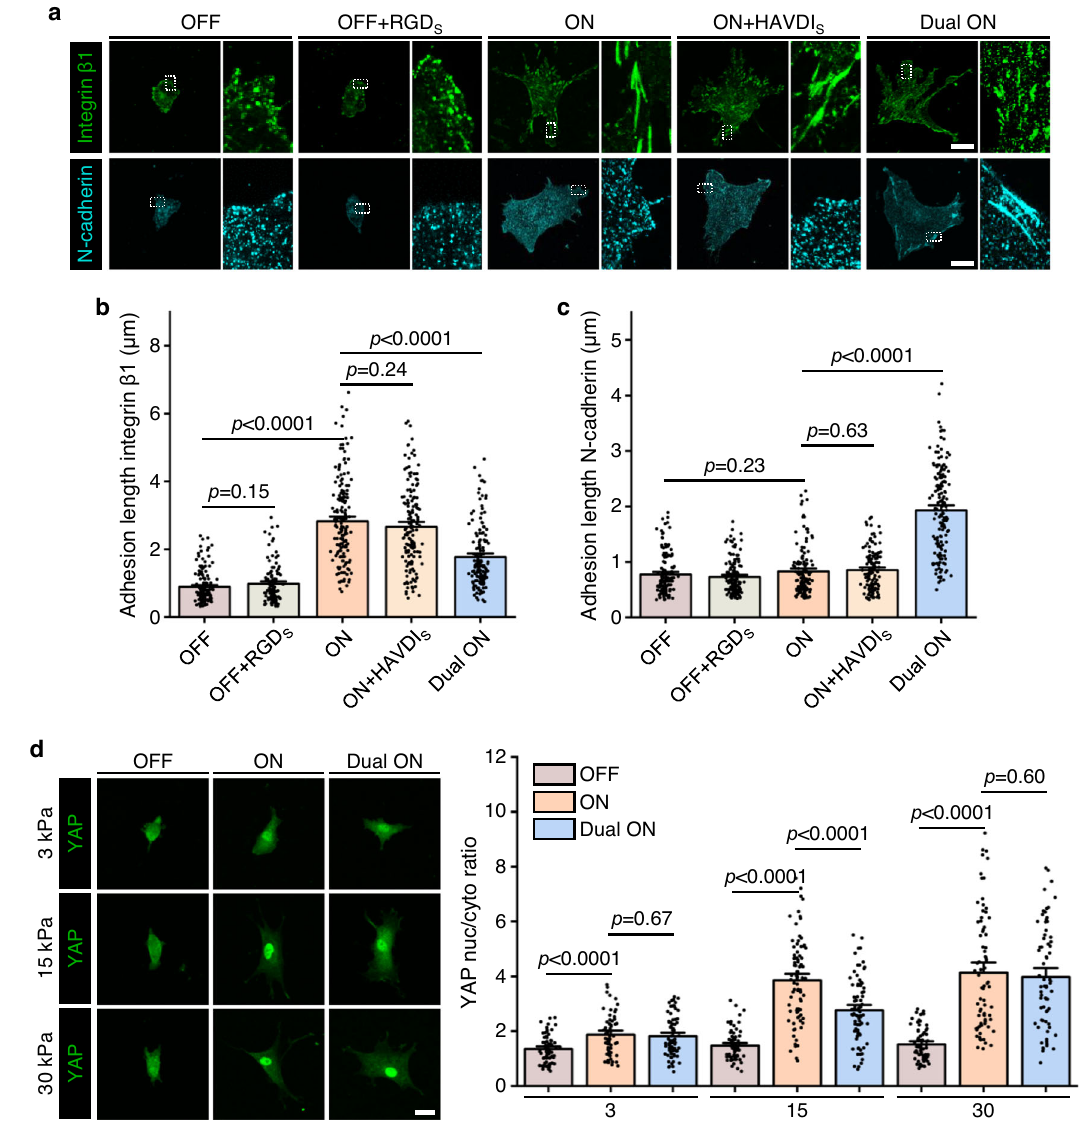
Fig. 2 | Integrin and N-cadherin clustering in hMSCs on various functionalized hydrogels and stiffness-dependent YAP nuclear localization associated with integrin and N-cadherin signaling. a Representative integrin β 1 and N-cadherin imagesinhMSCsonvariousfunctionalizedsubstrates(15kPa)for1d.Thesubscript S indicated that RGD S and HAVDI S were the scrambled sequence of RGD and HAVDI, respectively. RGD ligation caused integrin clustering, and HAVDI ligation caused N-cadherin clustering. b Corresponding quanti fi cation of integrin β 1 adhesion length from immuno fl uorescence images for the same conditions as a (from left to right n = 146, 122, 172, 151, 159 adhesions in 44, 38, 53, 45, 48 cells,